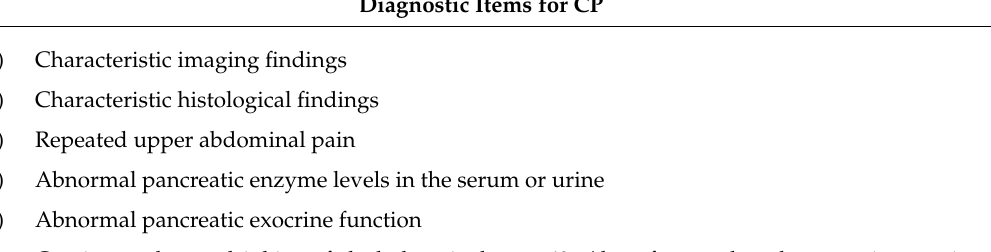
Table 2. Clinical diagnostic criteria for CP in 2019 by JPS.